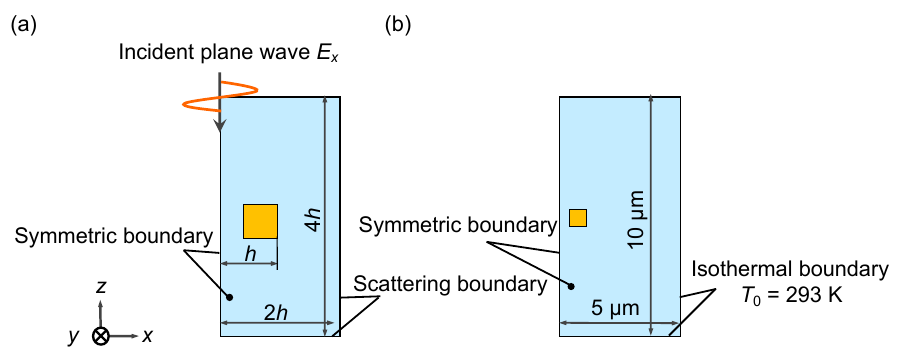
Figure 4. Boundary conditions for ( a ) electric and ( b ) temperature fields calculations.